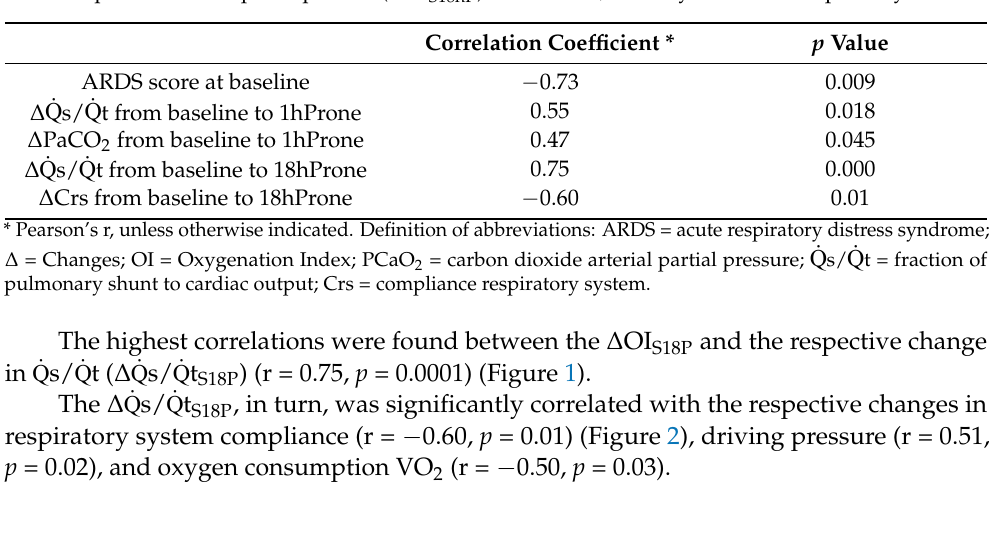
cumbent posture to 18 h prone posture ( ∆ OI S18hP ) and clinical, hemodynamic and respiratory